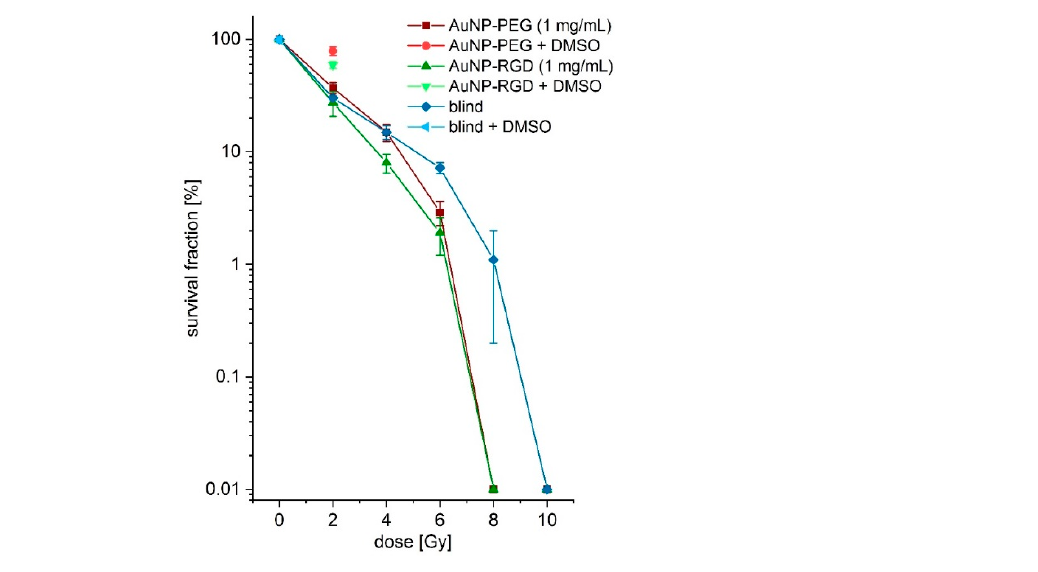
Figure 5. Survival fractions in logarithmic scale of the colony formation assays at different X-ray doses (0–10 Gy) with AuNPs 1 (red), AuNPs 7 (green), and without AuNPs (blue) incubation. Single colony formation assays (CFAs) with DMSO are shown at 2 Gy for AuNPs 1 (light red) and AuNPs 7 (light green) and at 0 Gy in absence of AuNP (light blue).